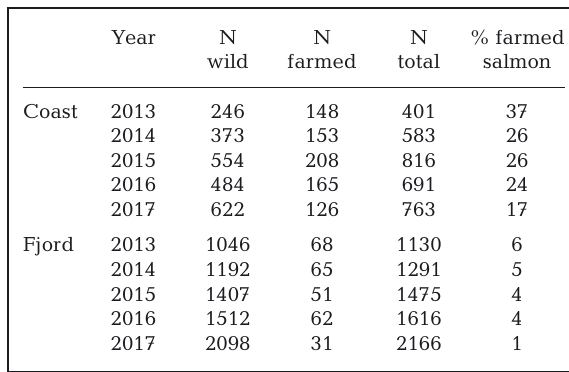
pled (GLMM: intercept (coast) estimate (±SE) = −1.09 ± 0.15, contrast fjord = −2.17 ± 0.09, z = −24.97, p < 0.0001). The mean (±SE) proportion of escapees was 26 ± 3 and 4 ± 0.7% on the coast and in the fjord, respectively. Table 1. Number (N) of wild and farmed Atlantic salmon, total number of salmon and percentage of escaped farmed salmon in the catches on the Norwegian coast and in the Namsfjord for the years 2013−2017. The total number of salmon caught includes cultivated individuals and individuals that could not be